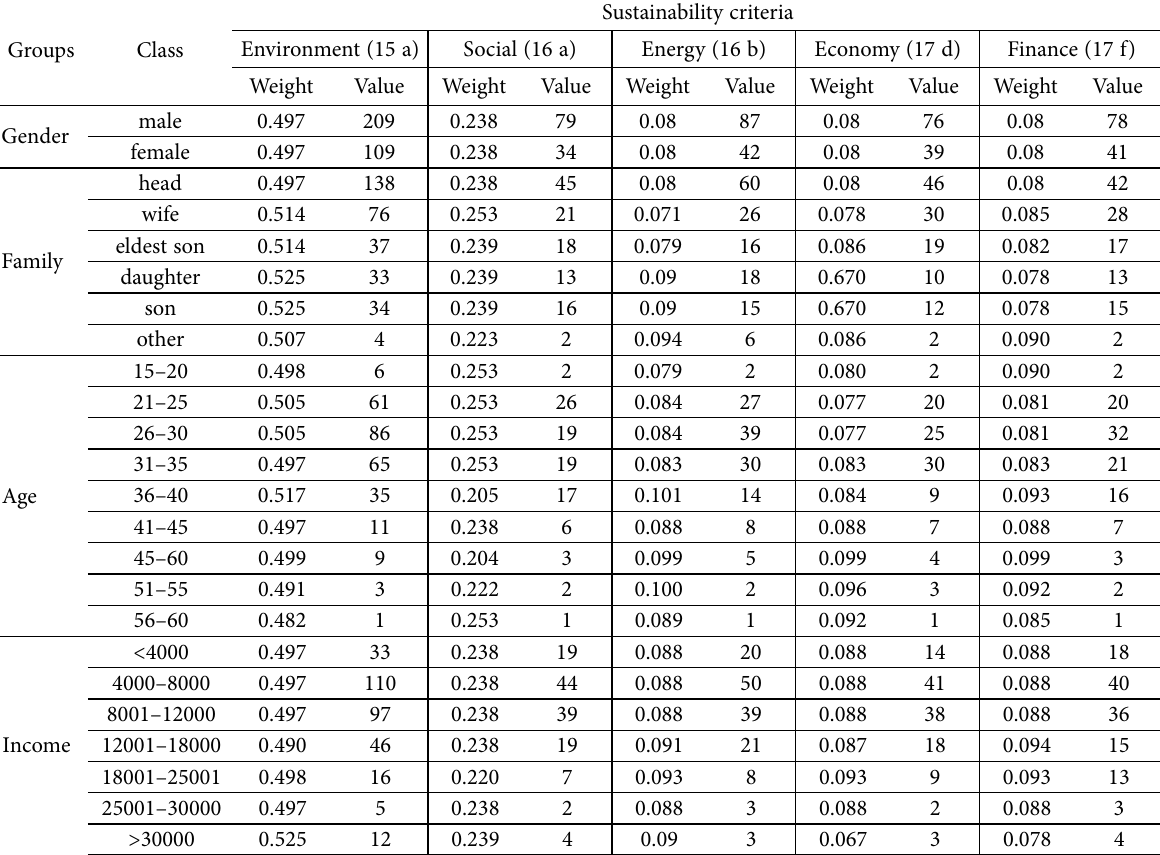
Table 3. Weight of sustainable criteria using AHP